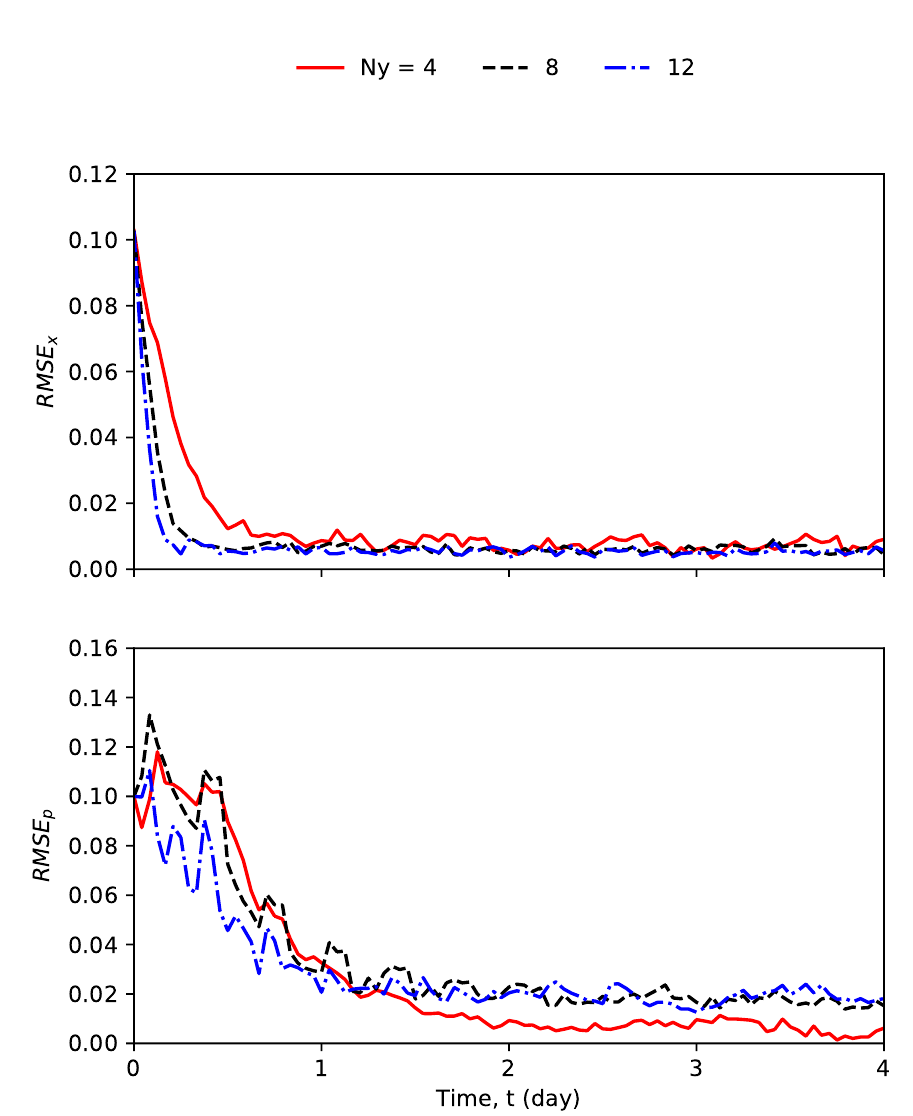
Figure 7. Trajectories of RMSE measuring the error between actual model and estimated states and parameters of MHE using 4, 8 and 12